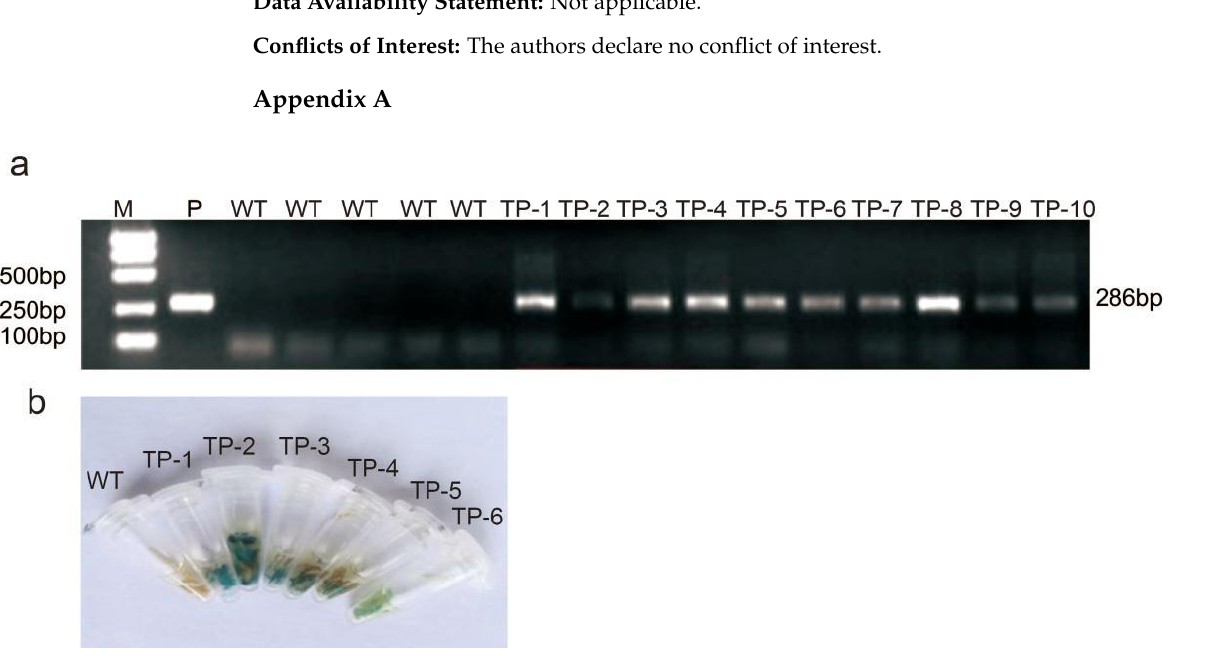
Figure A1. ( a ) PCR detection M: Marker DL2000 (TaKaRa, Japan) ( b ) GUS histochemical staining of transgenic tobacco.